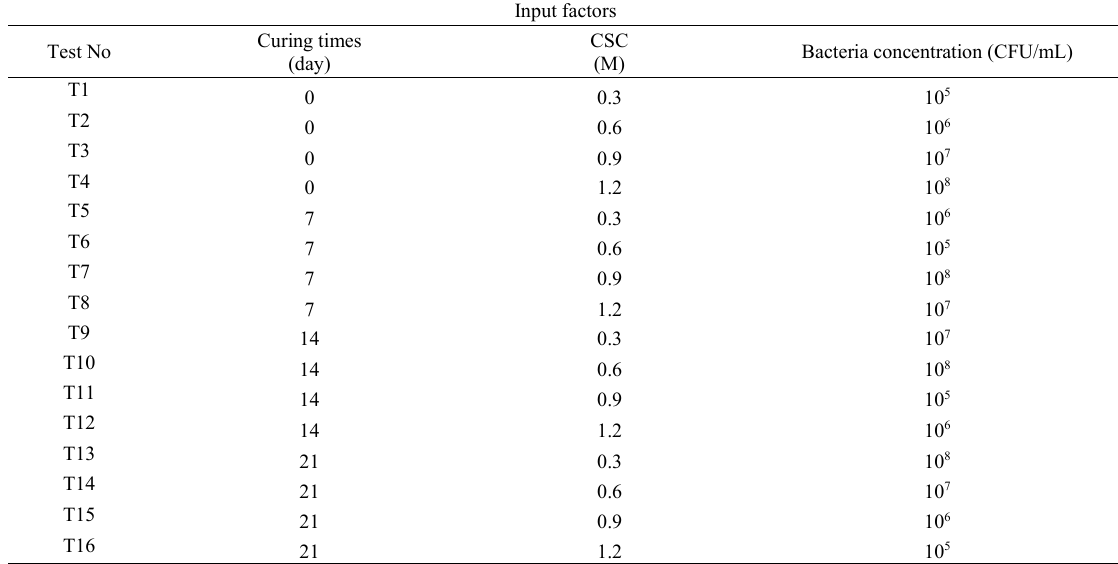
Table 3 : MICP treatment test program designed by Taguchi method